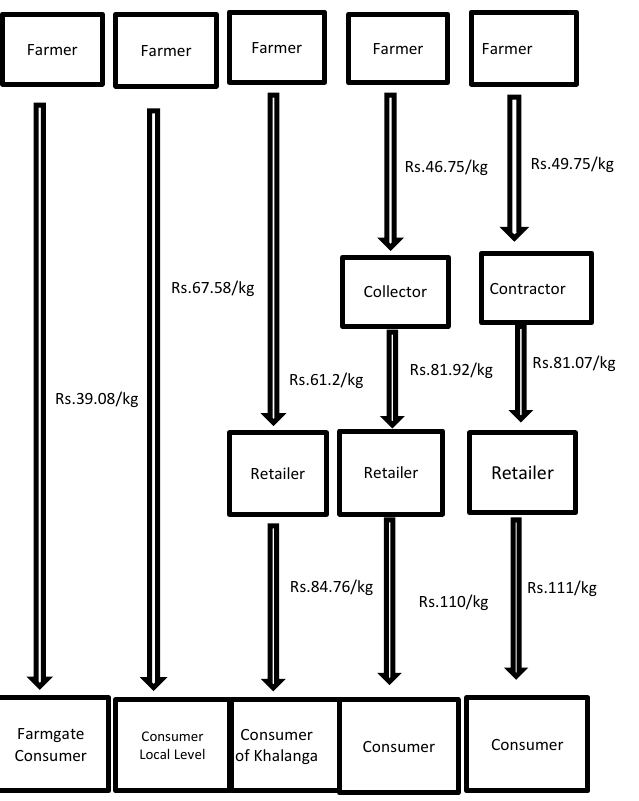
Figure 4: Market channels of Jajarkot district